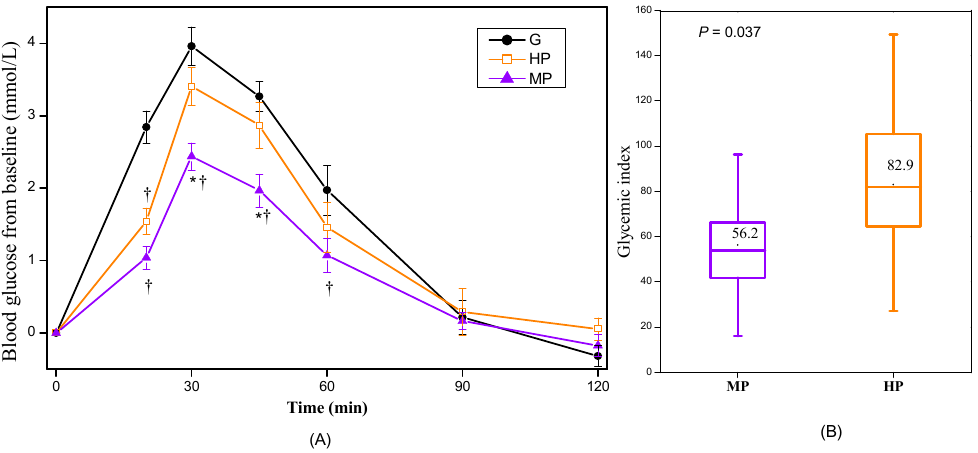
Figure 2. Glycemic responses of cooked potato samples (n = 17). G, glucose; P, potatoes; HP, highly cooked potato; MP, minimally cooked potato. ( A ) Blood glucose changes from baseline for potato samples. ( B ) The GI values of potato samples. Values are shown as the mean value with their standard errors represented by vertical bars. * HP different from MP, † HP, or MP different from G ( p < 0.05).